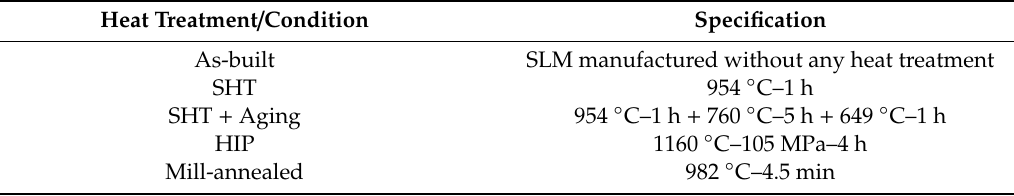
Table 2. Test plate